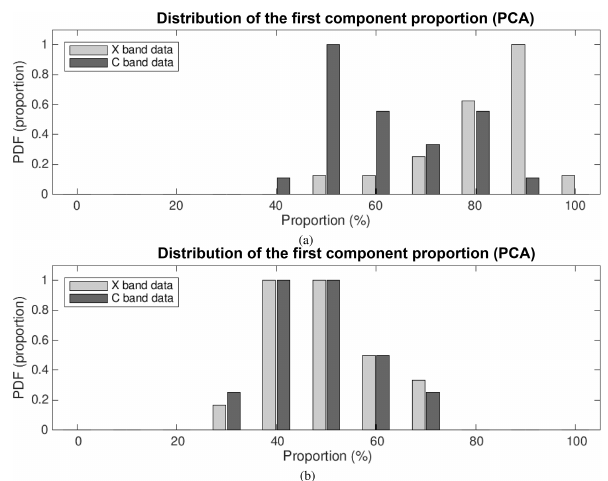
Figure 18. The distribution of the proportions of the most domi- nant component, calculated by generalizing the analysis illustrated in Figs. 16, 17 and 19 onto the entire (extended) event considered in the inter-radar comparison in Sect. 3.1: (a) PCA, (b)